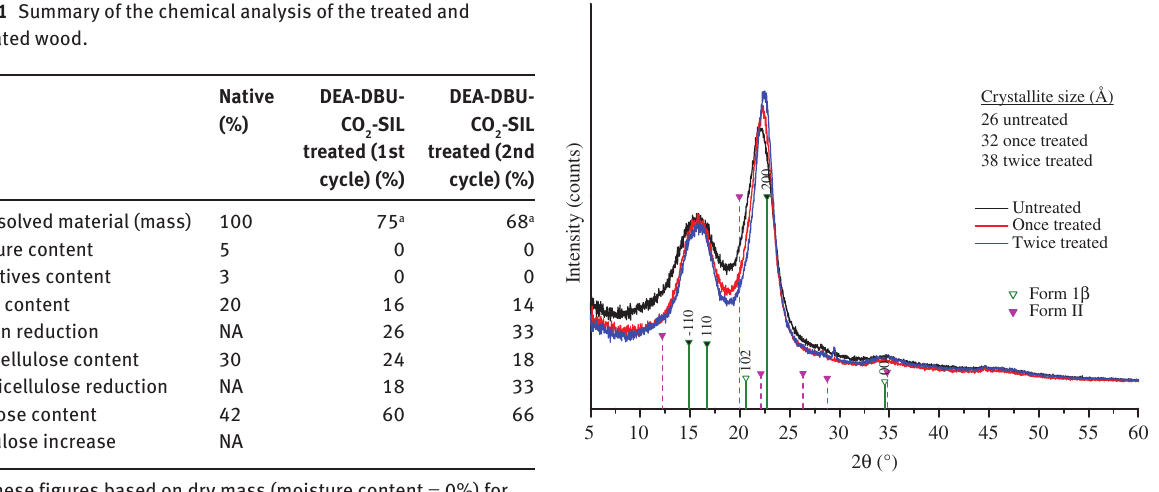
Figure 3 The X-ray diffraction (XRD) patterns of untreated, once-treated and twice-treated birch chip using diethanolamine (DEA)-CO2-switchable ionic liquid (SIL). Fresh SIL was applied for the first as well as the second treatment at 100 °